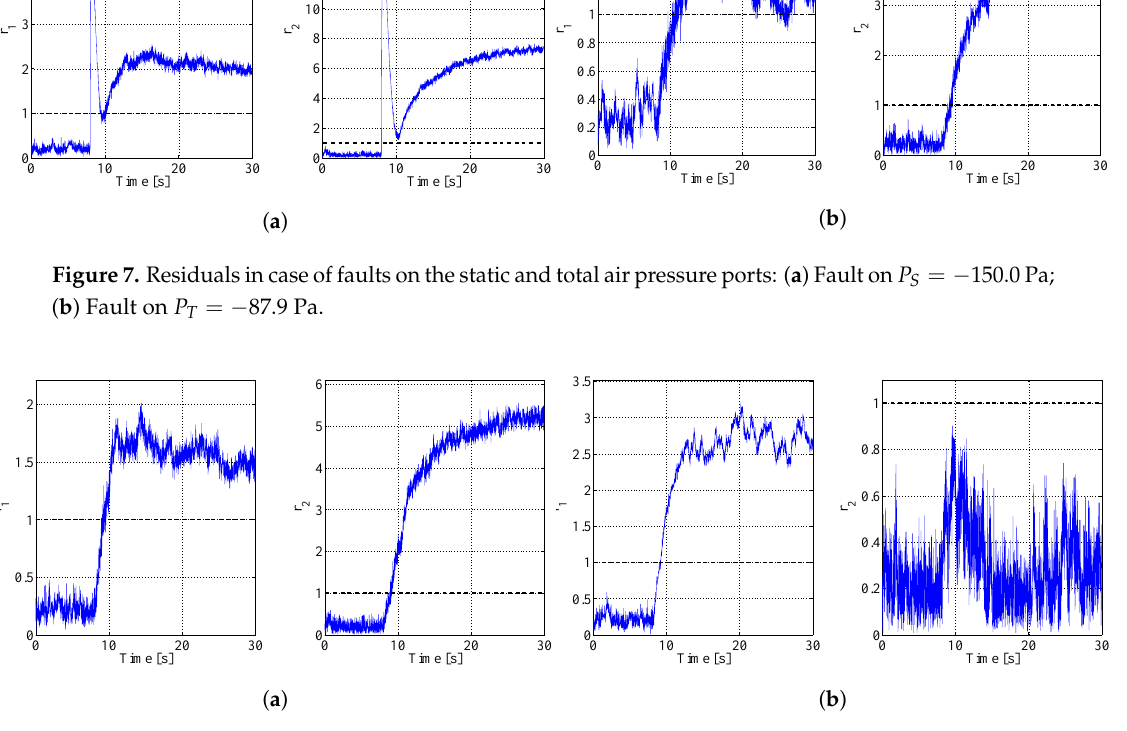
Figure 8. Residuals in case of faults on the total air temperature ports and the angle of attack vane sensor: ( a ) Fault on θ T = − 15.5 ◦ C; ( b ) Fault on α = 0.34